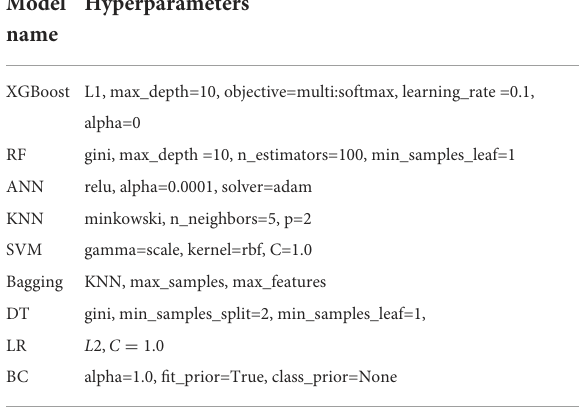
TABLE 2 Model optimal